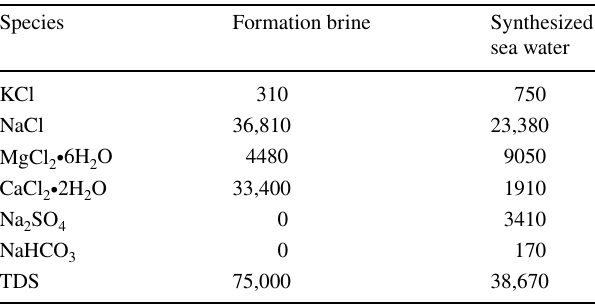
Table 1 The composition of formation brine and synthesized sea water (ppm)